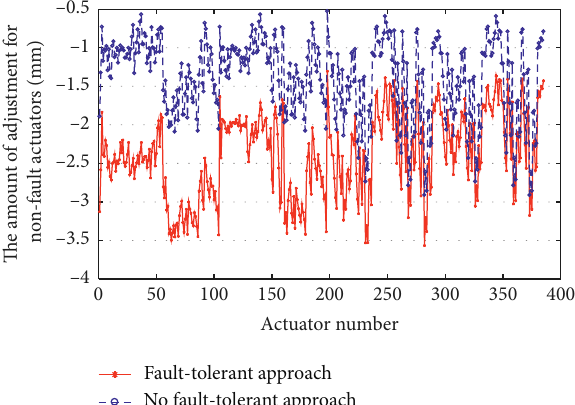
Figure 9: Nonfault actuators’ stroke at 35 deg